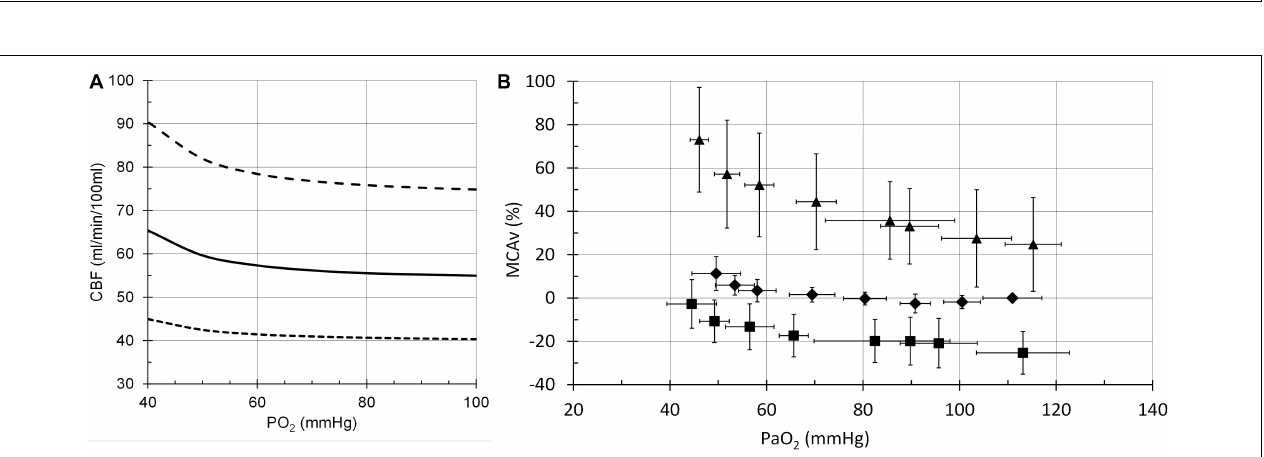
Frontiers in Physiology |